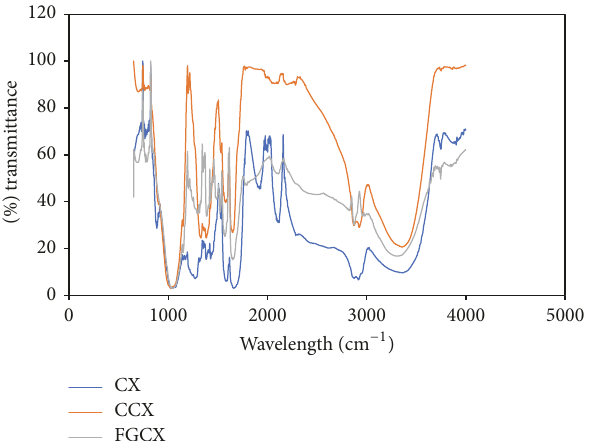
Figure 5: FTIR of chitosan and cross-linked chitosan beads.